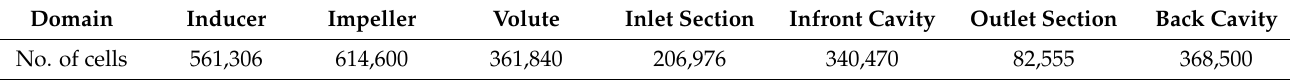
Table 3. Mesh No. of each